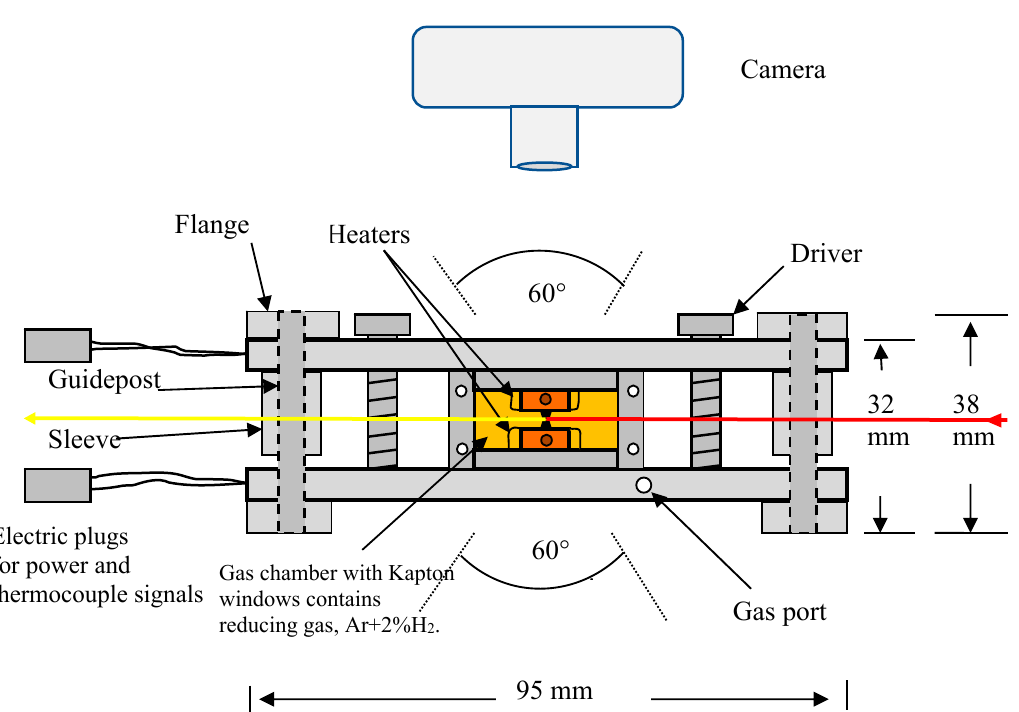
Figure 3. Diagram of diamond anvil cell model HDAC-5, suitable for spectrometric analysis because it provides side access for the X-ray beam to enter and exit the sample, while both the camera and the spectrometer have access to the sample at 90° to the X-ray beam. The main X-ray beam enters from the right at 45° to the page normal and the emitted X-rays to be analyzed exit to the left at 45° to the page normal. The camera is above looking through the upper anvil.